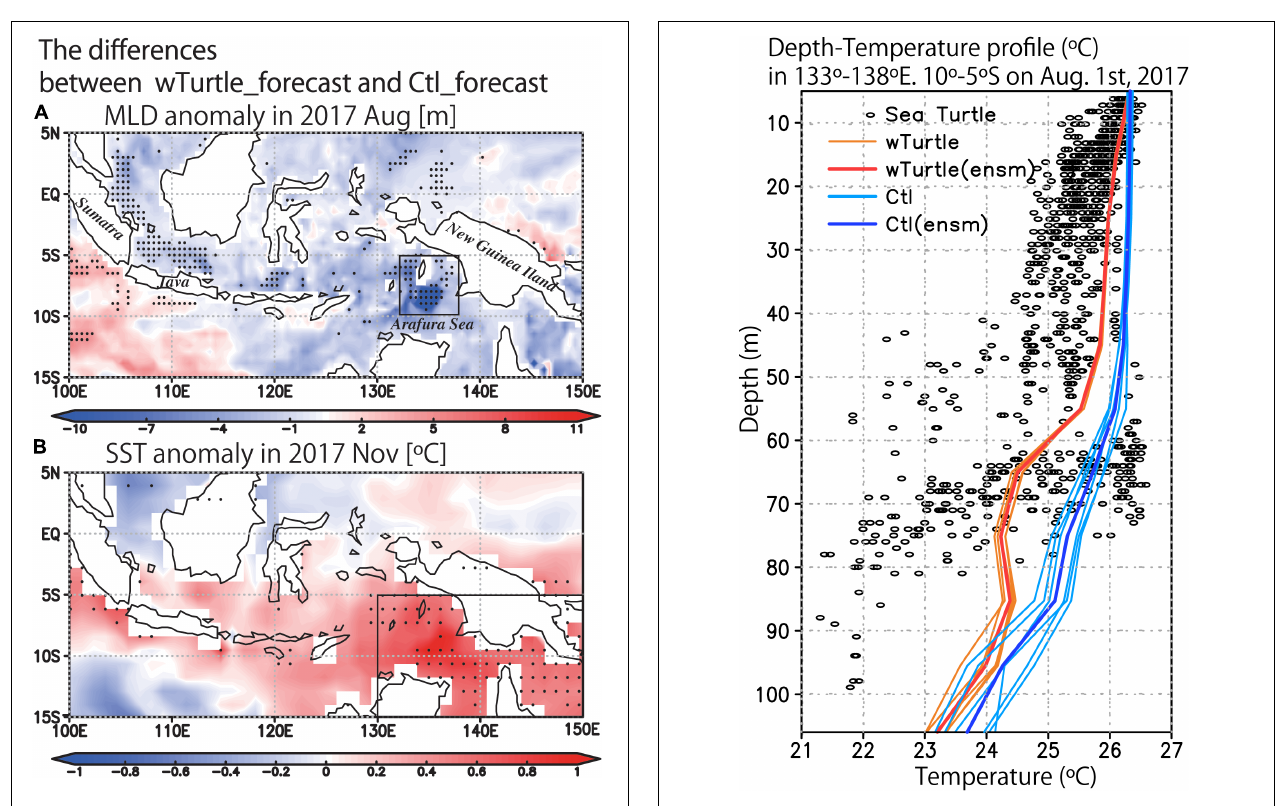
FIGURE 4 | The depth–temperature profiles in 133 ◦ –138 ◦ E and 10 ◦ –5 ◦ S on the August 1, 2017, initialization. Circle mark shows the observation from sea turtles assimilated to the seasonal prediction system in this region (976 points). The regional averages of the depth-temperature profiles in 133 ◦ –138 ◦ E, and 10 ◦ –5 ◦ S on the August 1, 2017, initialization with the six-ensemble members by Ctl_forecast (thin right blue, each ensemble member; thick blue, ensemble mean) and the six-ensemble members by wTurtle_forecast (thin orange, each ensemble member; thick red, ensemble mean) are